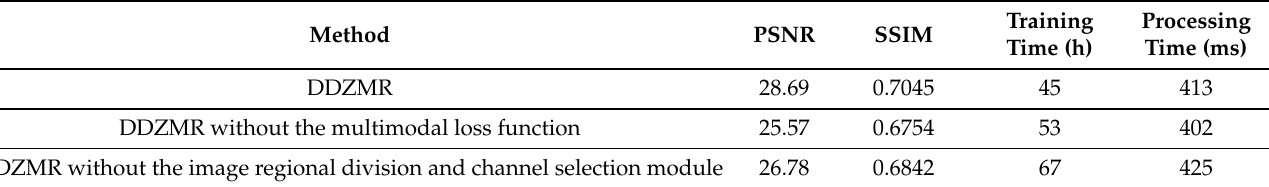
Table 1. Quantitative comparison of ablation multi-modal loss function and area division and channel planning modules.